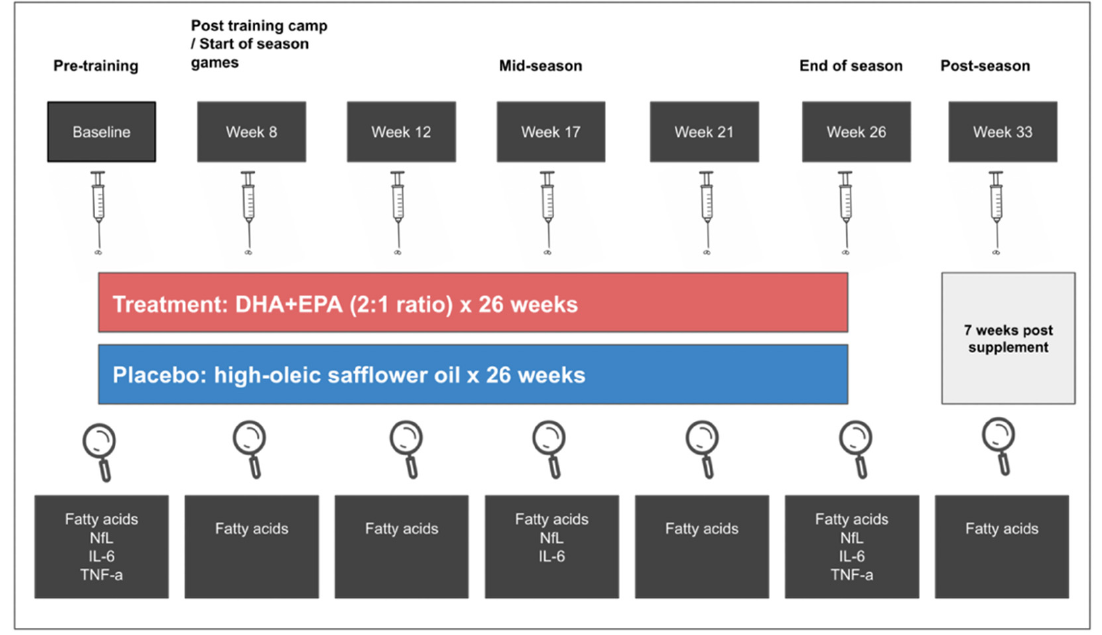
Figure 2. Schematic of the intervention